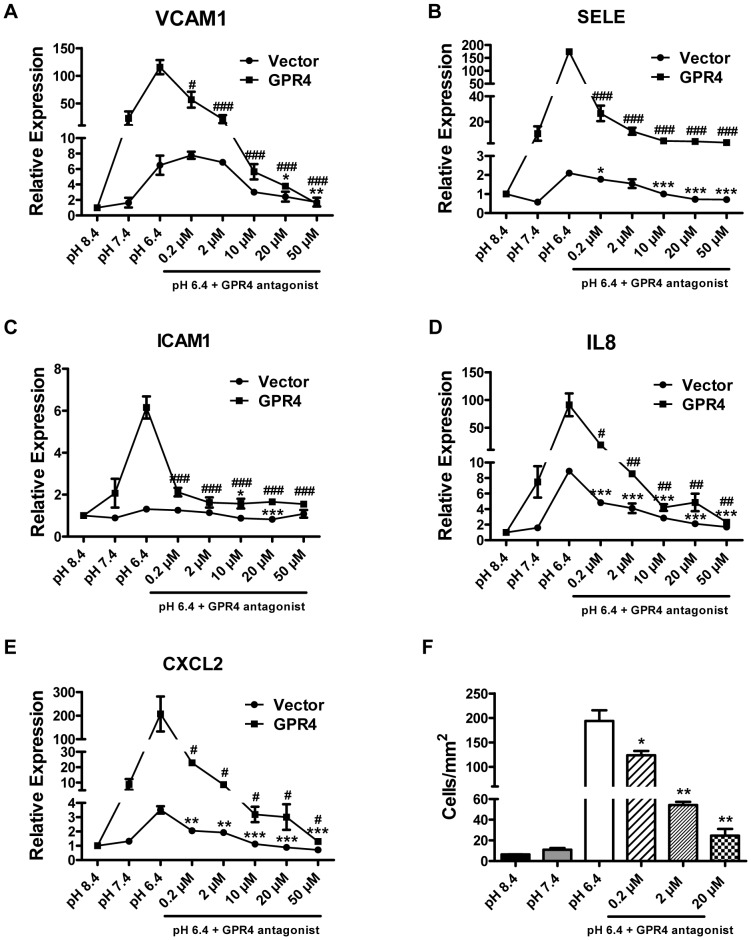
Inhibition of GPR4 activation by its antagonist attenuates the expression of inflammatory genes.(A–E) HUVEC/Vector or HUVEC/GPR4 cells were treated for 5 h with EGM-2/HEM pH 8.4, 7.4 or 6.4 media, or with pH 6.4 media containing indicated concentrations of GPR4 antagonist. Total RNA was isolated and cDNA was synthesized. Real-time RT-PCR quantification of gene expression of VCAM1 (A), SELE (B), ICAM1 (C), IL8 (D) and CXCL2 (E) was performed. The expression level of the target gene in HUVECs at pH 8.4 was set as 1. Error bars indicate the mean ± SEM. *, P<0.05; **, P<0.01; ***, P<0.001; compared with the pH 6.4 vehicle control in HUVEC/Vector cells. #, P<0.05; ##, P<0.01; ###, P<0.001; compared with the pH 6.4 vehicle control in HUVEC/GPR4 cells. The results shown are the average of at least two biological repeats. (F) HUVECs stably overexpressing GPR4 were grown to form a monolayer. Cells were then pretreated with vehicle or GPR4 antagonist (at indicated concentrations) for 1 h, followed by the treatment with indicated pH media or pH 6.4 medium containing indicated concentrations of GPR4 antagonist for 5 h. The static cell adhesion assay was then performed using U937 monocyte binding as a functional readout as previously described [13]. Error bars indicate the mean ± SEM. *, P<0.05; **, P<0.01; compared with the pH 6.4 vehicle group. The results represent the average of cell counts from 3 fields under an inverted microscope (total 100× magnification).